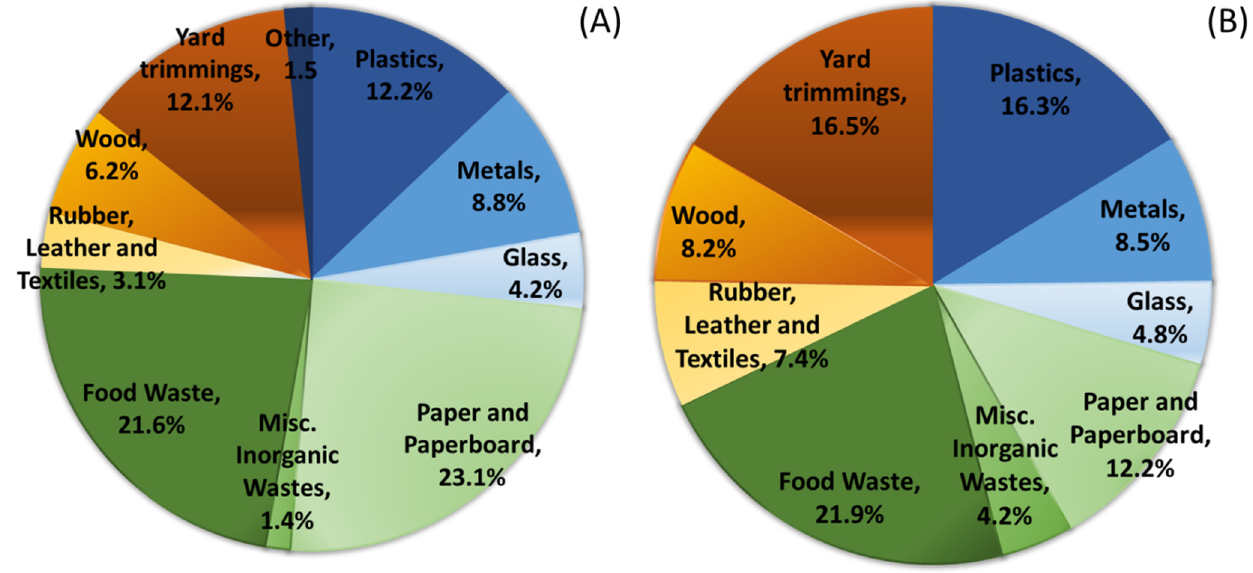
Figure 4. ( A ) The percentage distribution of USA MSW composition, 2018 (265.53 MM tons), and ( B ) The percentage distribution of energy recovery by combustion in U.S.A. (33.7 MM tons) [65].